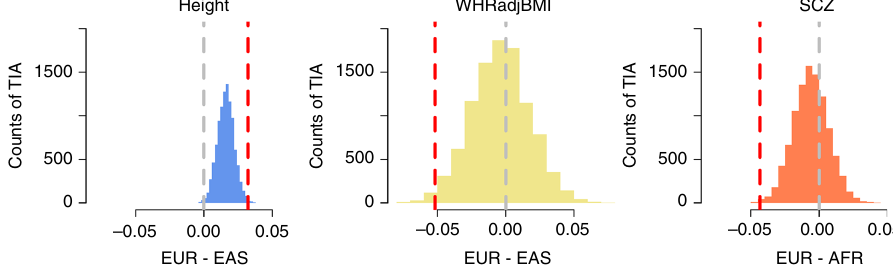
Fig. 3 Mean difference in frequencies of the trait-increasing alleles between two 1000G populations for height, WHRadjBMI and SCZ. The red dashed line represents the mean difference in fTIA of the trait-associated SNPs clumped at P < 5 ´ 10 (cid:2) 6 . The histogram represents the distribution of the difference in fTIA for the control SNPs. The gray dashed line represents the expected difference in fTIA (i.e., 0) under genetic drift. WHRadjBMI, waist-to-hip ratio adjusted by BMI; SCZ schizophrenia, EUR European, AFR African, EAS East Asian